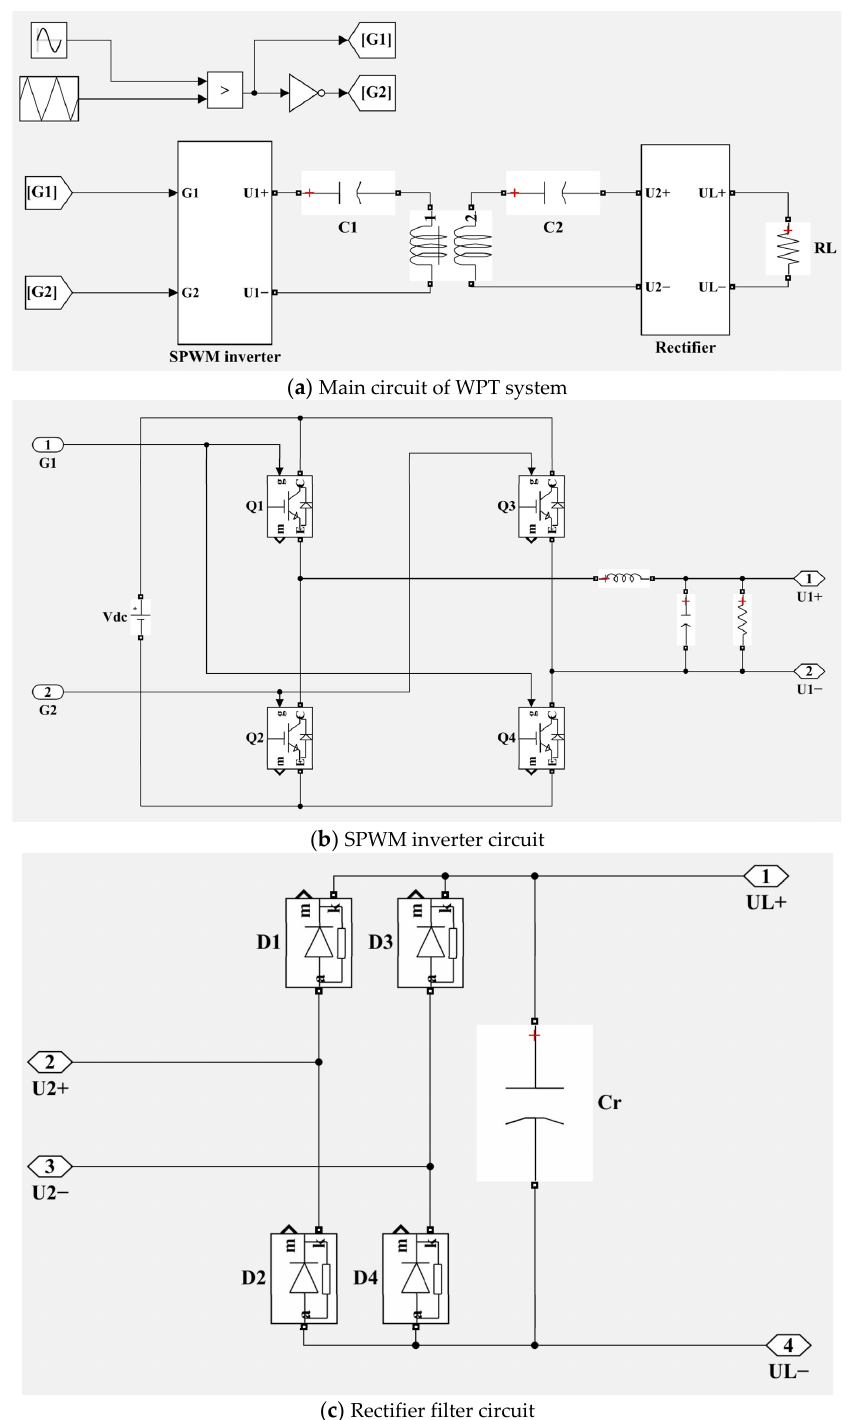
Figure 9. The Simulink circuit model of the WPT system. The amplitude of the triangle wave signal generator was set as unit 1. The amplitude of the sinusoidal signal generator was calculated by Equations (10) and (13) according to